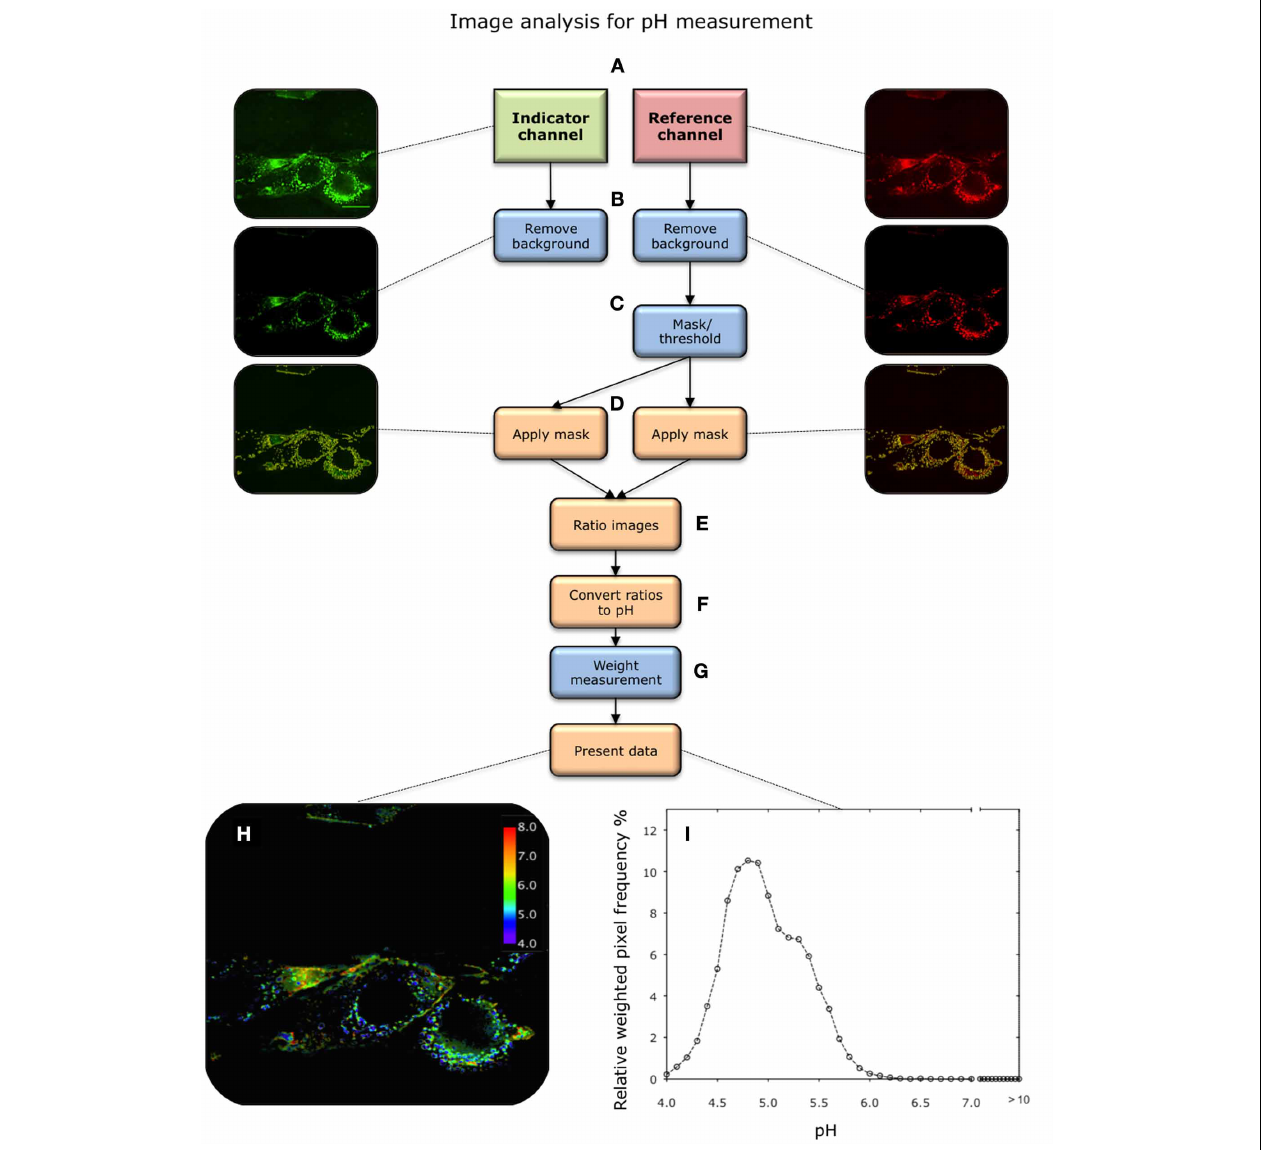
FIGURE 4 | Overview of image analysis procedure for pH measurement. (A) Images are acquired in the indicator (green) and reference (red) channels after nanosensor uptake. The central most in-focus slice selected for analysis. (B) Background is removed in both channels. (C) Pixels containing nanosensor signal are isolated from the image. This is achieved by applying a threshold to the reference image, above which pixels are considered to